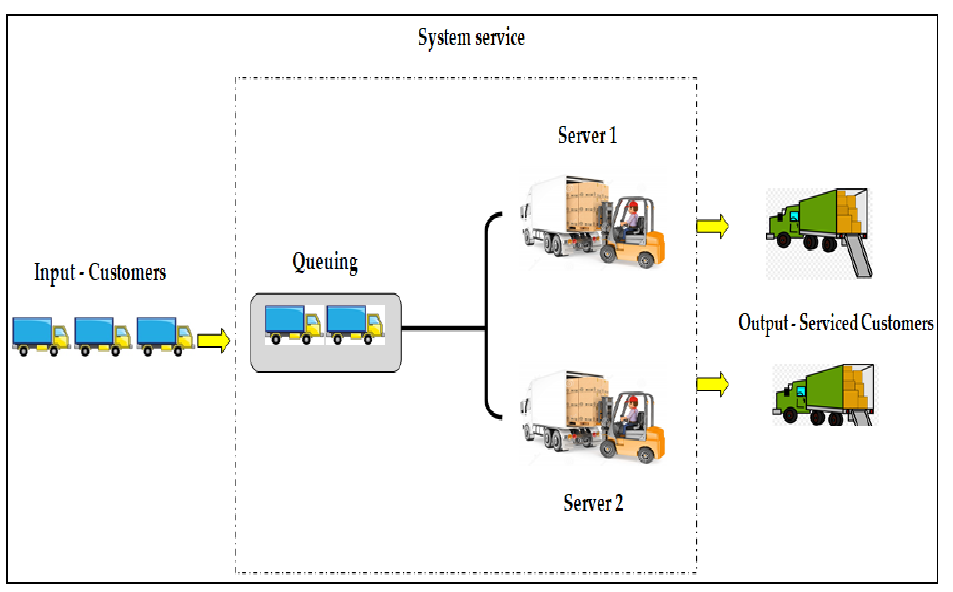
Figure 2. The ANFIS structure with two inputs.